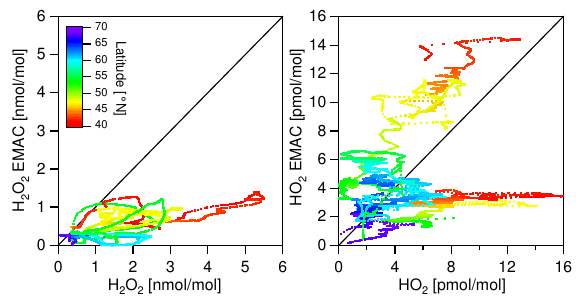
Fig. 9. Correlation of simulated H 2 O 2 by EMAC with mea- sured H 2 O 2 and from simulated HO 2 and measured HO 2 during HOOVER 1 in October 2006. The data is colour coded by the latitude of sampling. Apart from the Mediterranean region (red and yellow), HO 2 simulations reproduce the measured values rea- sonably well, whereas H 2 O 2 is permanently underestimated by the model.